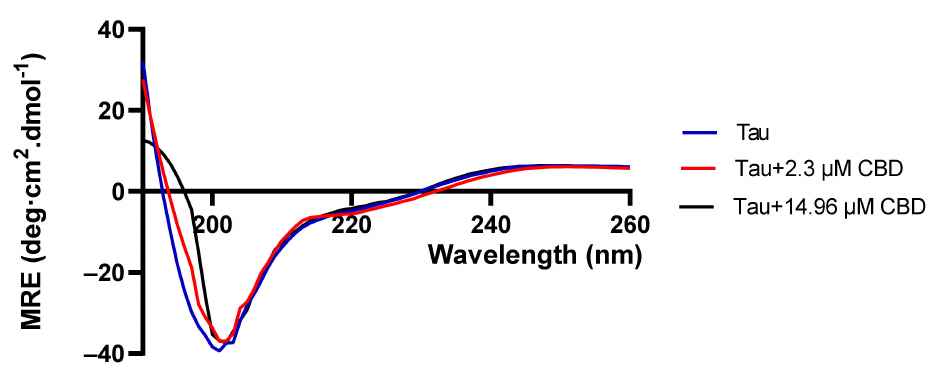
Figure 4. Far-UV spectra in order to find out about CBD effect on tau protein structure. CBD transforms tau protein’s structure. Tau protein was incubated with CBD at concentrations of 2.3 µ M and 14.96 µ M for 30 min at 37 ◦ C. Three independent experiments (n = 3) were performed to record the